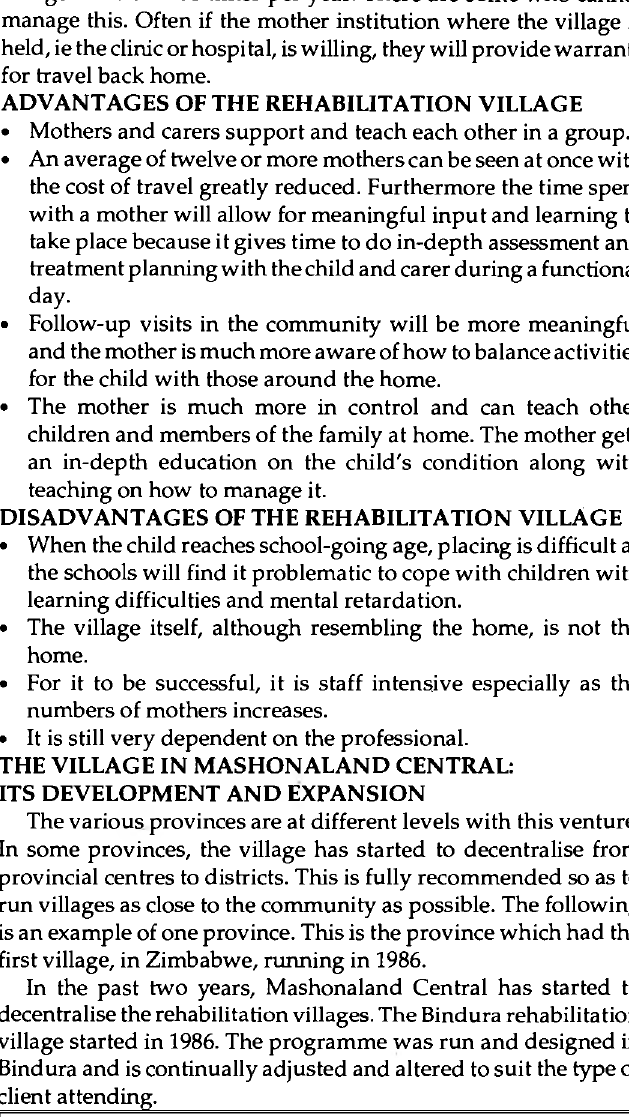
TABLE 1: NUMBER OF VILLAGES IN MASHONALAND CENTRAL